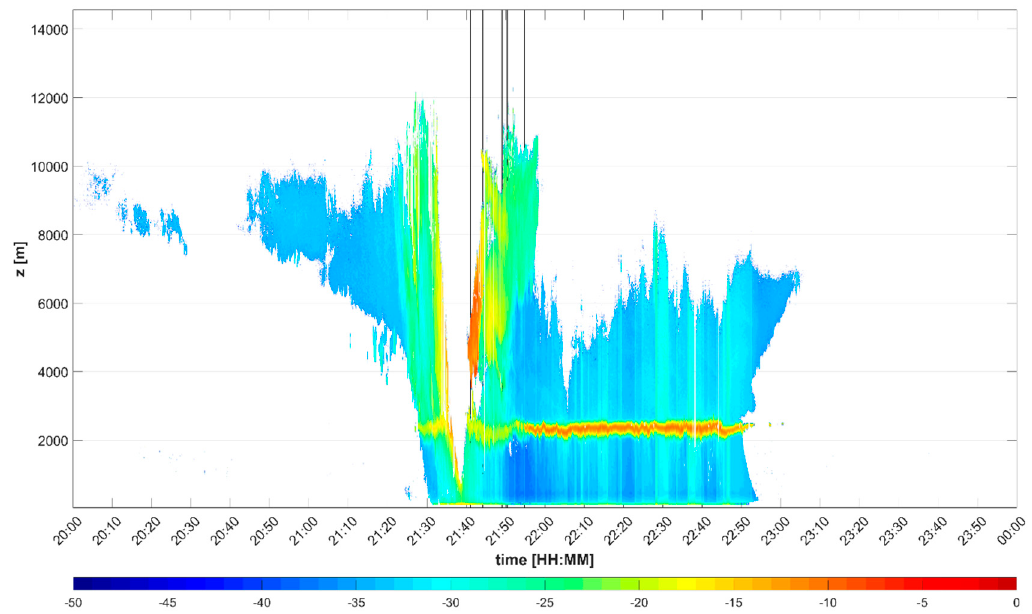
Figure 5. Temporal evolution of linear depolarization ratio (LDR) [dB] during the thunderstorm on 10 June 2019 from 20 to 24 h UTC at the Milešovka observatory. Vertical (black) lines depict CG NL discharges and y-axis (z [m]) displays the height in meters above the cloud radar situated at an elevation of 837 m a.s.l.